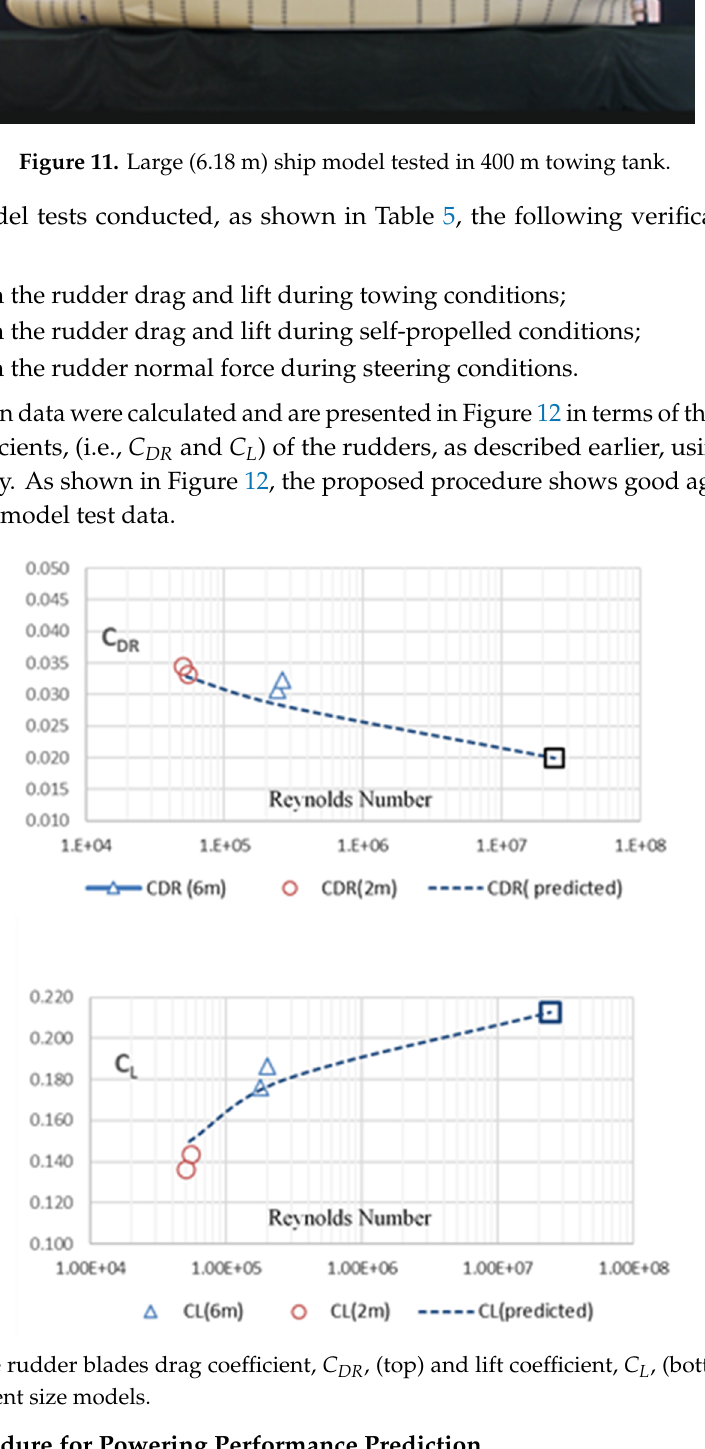
Table 5. Model tests conducted with two scaled models.